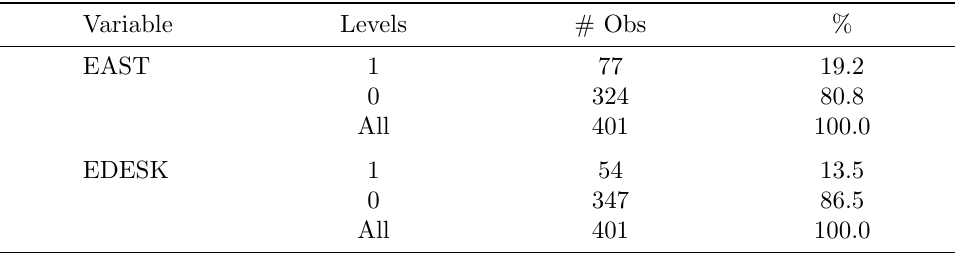
Table 2: Descriptive statistics for categorical